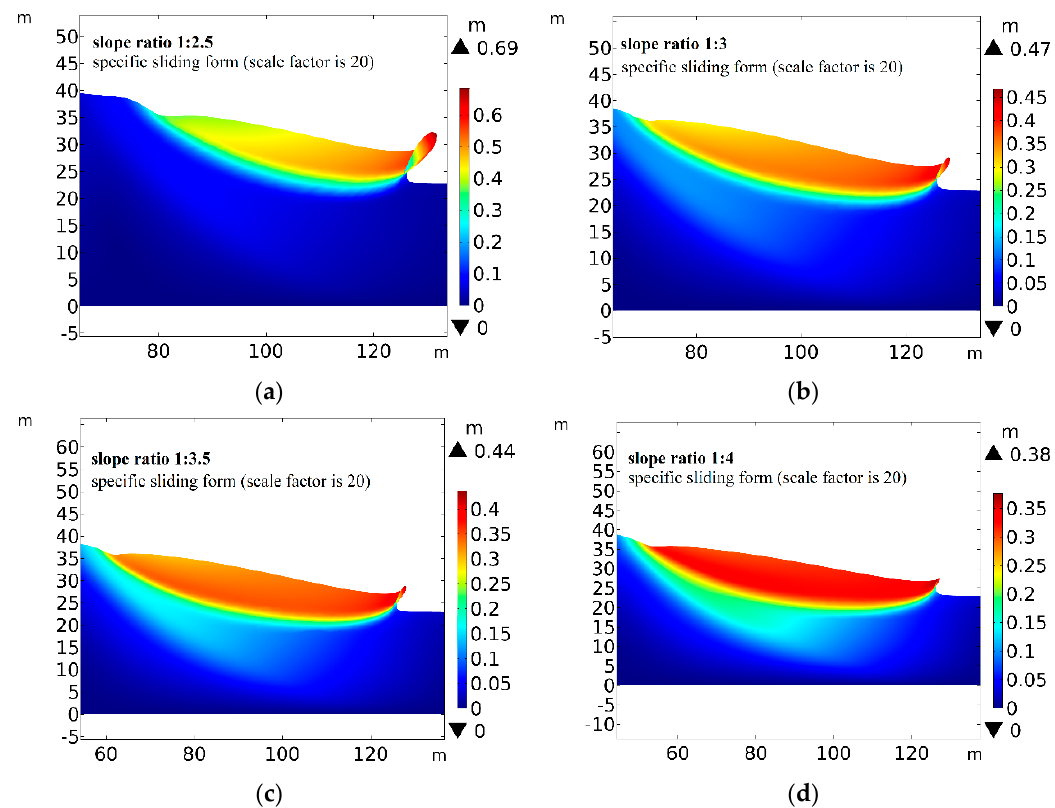
Figure 9. Sliding displacements in the slope with different slope ratios (scale factor is 20): ( a ) slope ratio 1:2.5, ( b ) slope ratio 1:3, ( c ) slope ratio 1:3.5, ( d ) slope ratio 1:4.